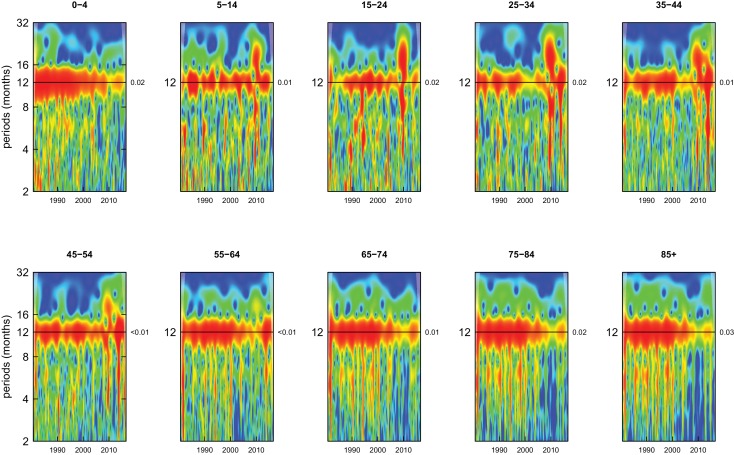
Wavelet power spectra for national time series of respiratory infection death rates for 1980–2016, by age group for females.Wavelet power values increase from blue to red. The shaded regions at the left and right edge of each box indicate the cone of influence, where spectral analysis is less robust. P-values for the presence of 12 month seasonality are to the right of each figure at the 12 month line.